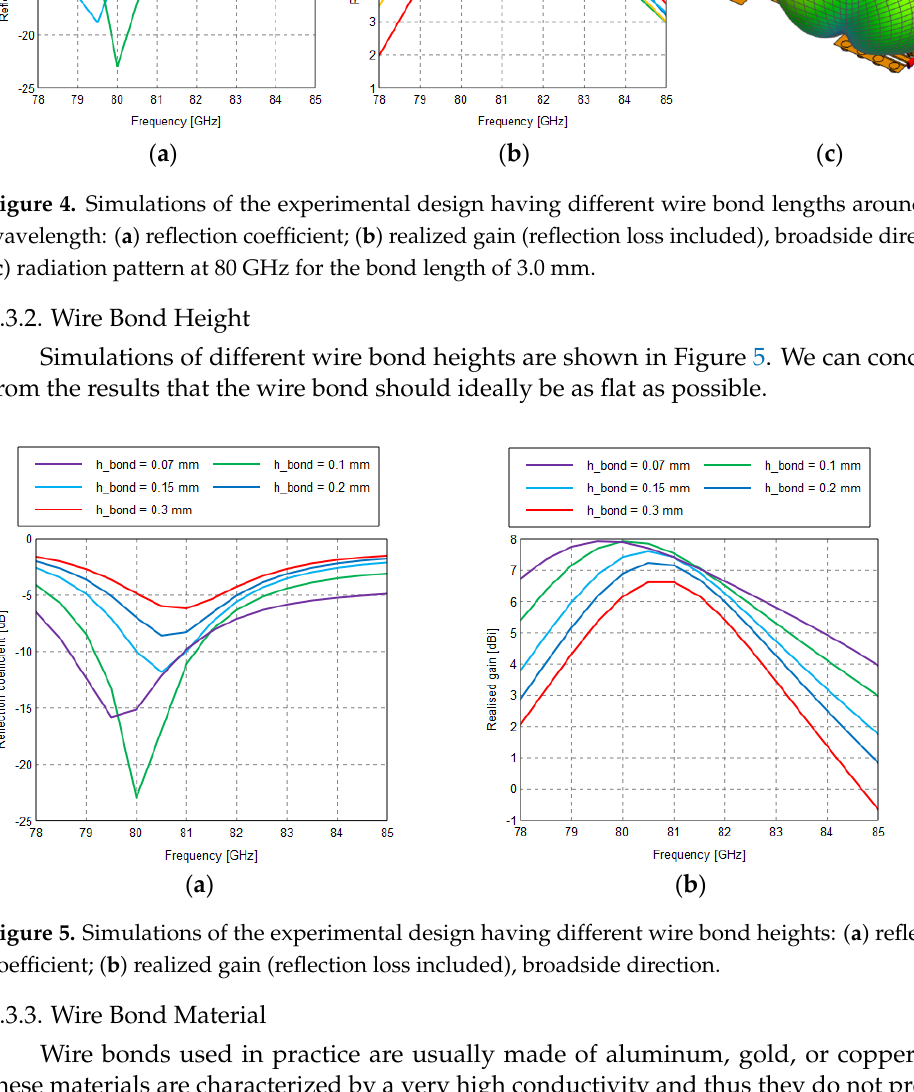
Figure 4. Simulations of the experimental design having different wire bond lengths around one wavelength: ( a ) reflection coefficient; ( b ) realized gain (reflection loss included), broadside direction; ( c ) radiation pattern at 80 GHz for the bond length of 3.0 mm.